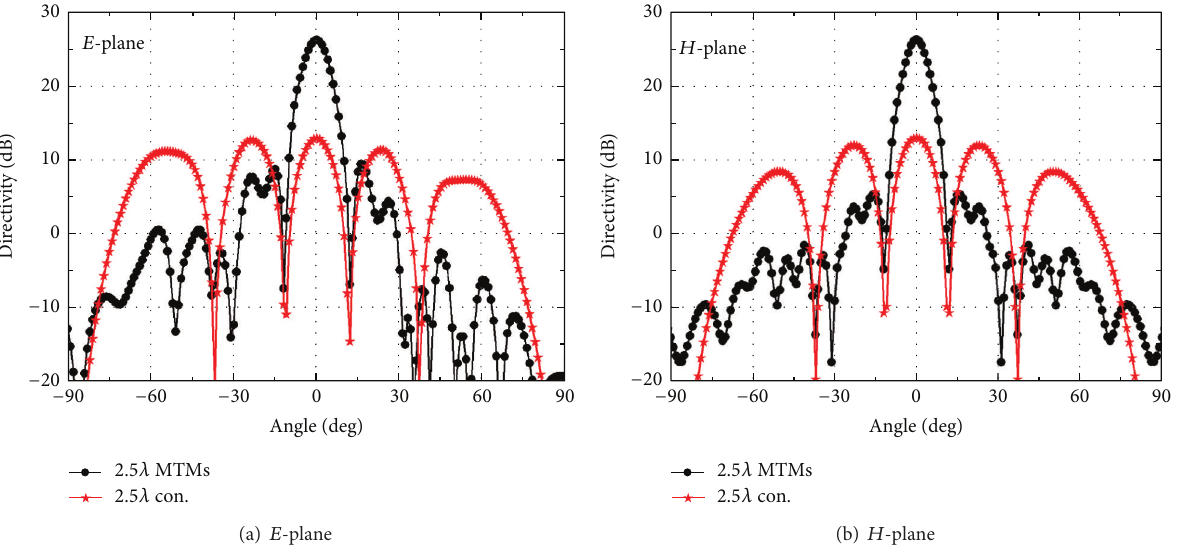
Figure 3: Radiation patterns of MTMs-cover array and the conventional type ( 𝐷 = 2.5𝜆 (14.6 GHz } ): (a) 𝐸 -plane; (b) 𝐻 -plane.